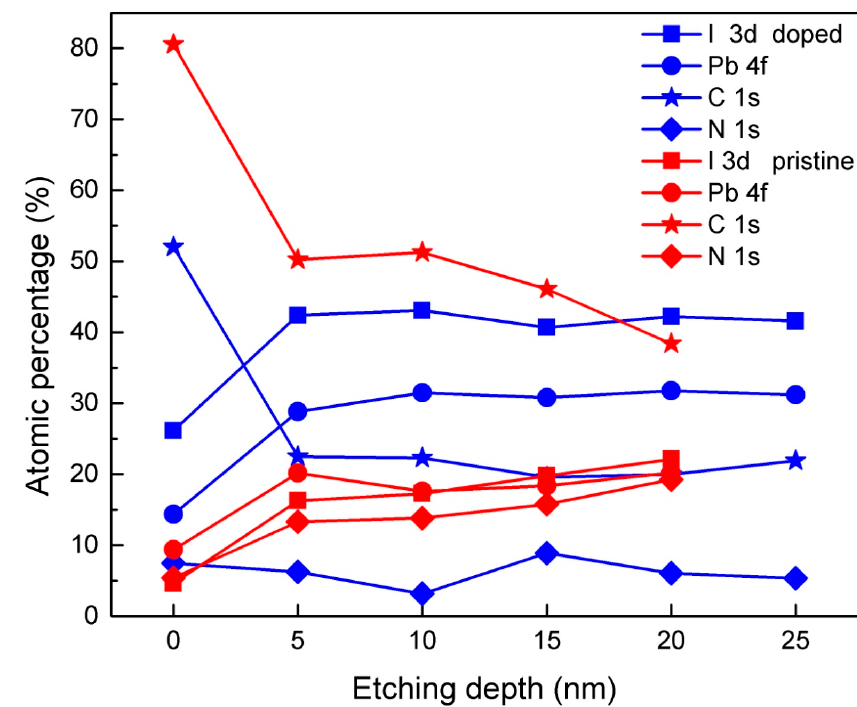
Figure 5. Atomic percentage of iodine-doped perovskite system and pristine perovskite system with the etching depth extracted from the XPS survey spectra. Table 1. I/Pb atomic ratio of iodine-doped perovskite and pristine perovskite with the etching depth.